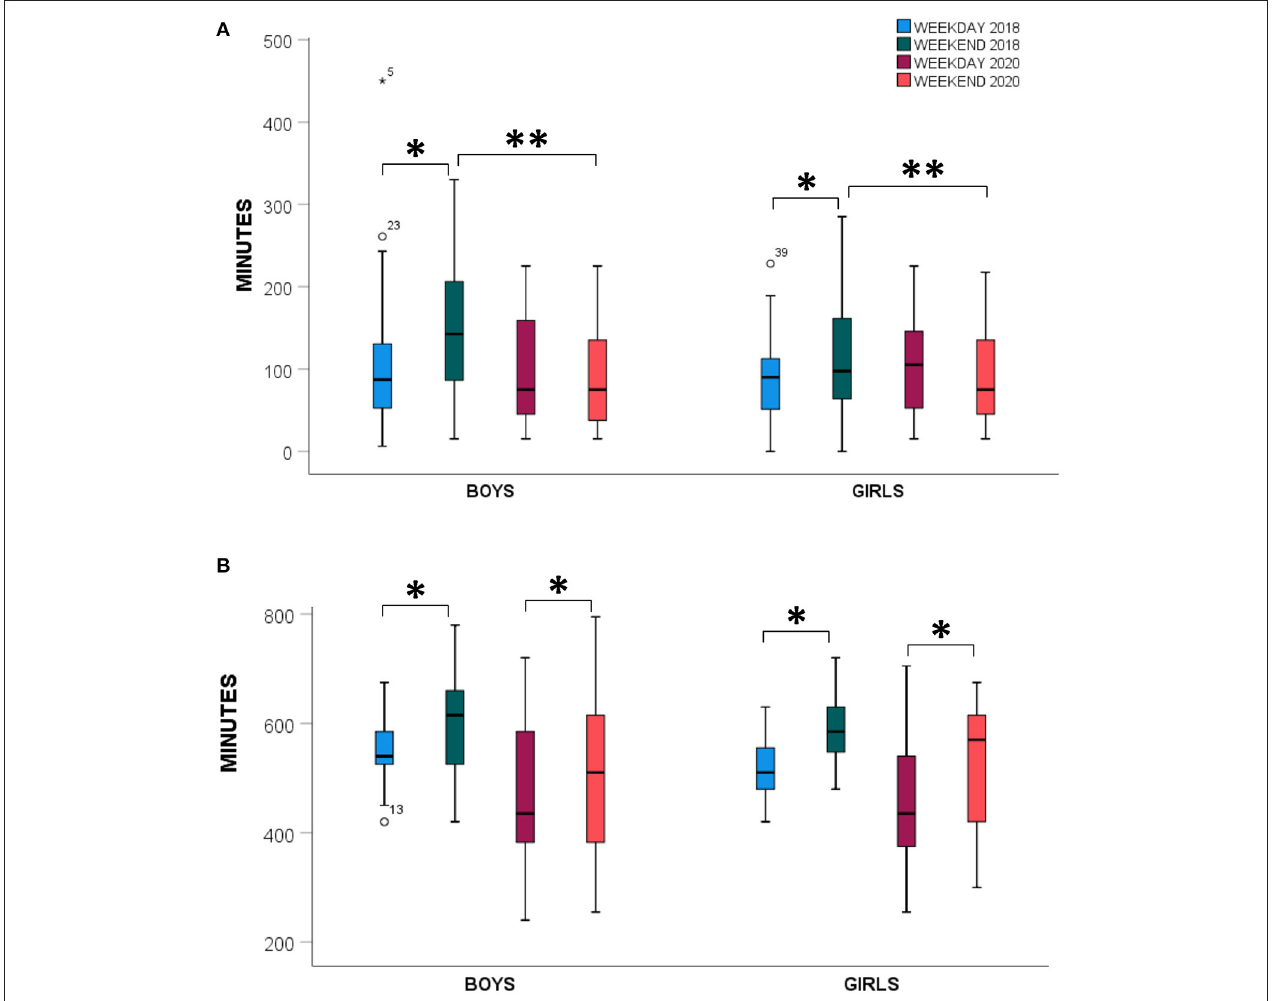
FIGURE 3 | (A) Self-reported cumulative screen time (min) for boys and girls during October 2018 weekdays (blue), October 2018 weekends (green), and during the COVID-19 lockdown weekdays (red) and weekends (orange). (B) Sleep duration (min) using identical coloring to (A) . *Indicates a significant main effect between time-points, **Weekend data are significantly different between 2018 and 2020 ( p <